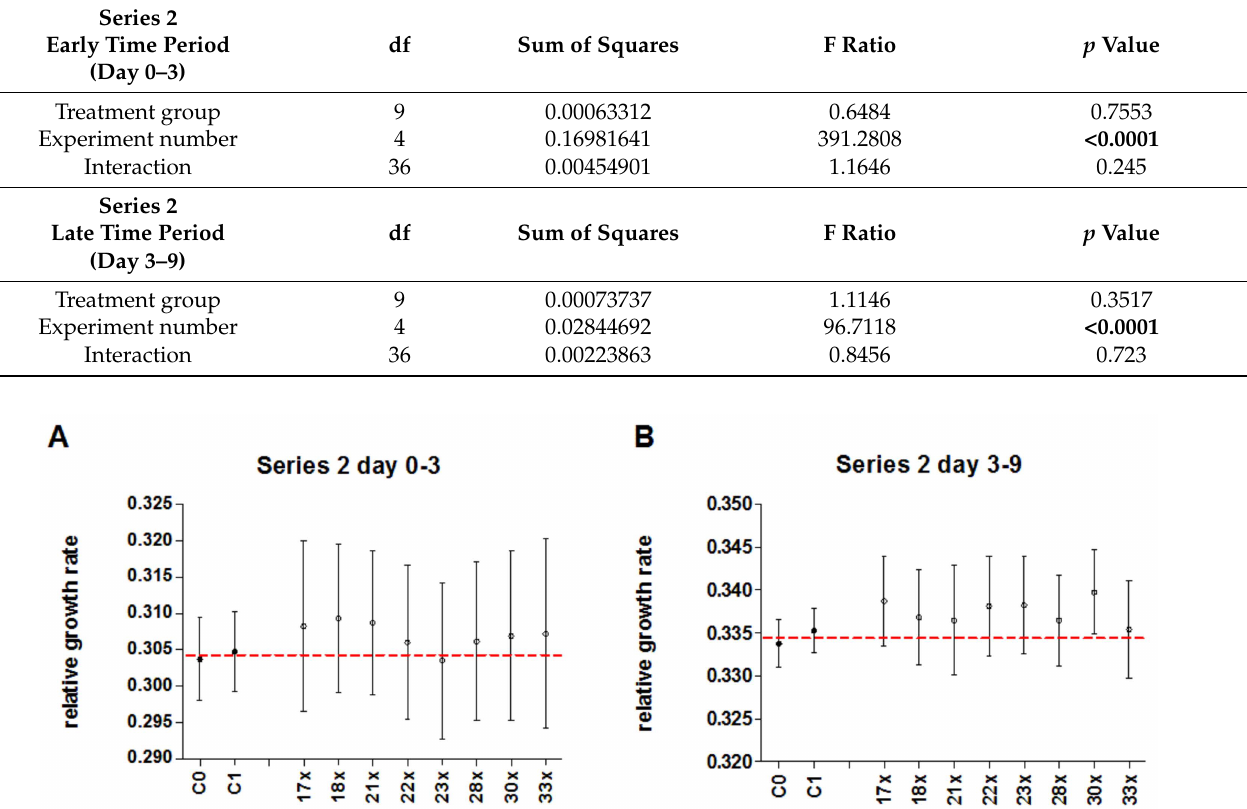
Figure 8. Mean relative growth rate ( ± 95% CI) of duckweed treated with either potentised As 2 O 3 (potency levels 17x–18x, 21x–23x, 28x, 30x, 33x, n = 25 each) or water as control (unsuccussed and succussed water samples, n = 85 each) in n = 5 independent experiments of series 2. ( A ) Early time period (day 0–3), ( B ) Late time period (day 3–9). The red line represents the mean of water